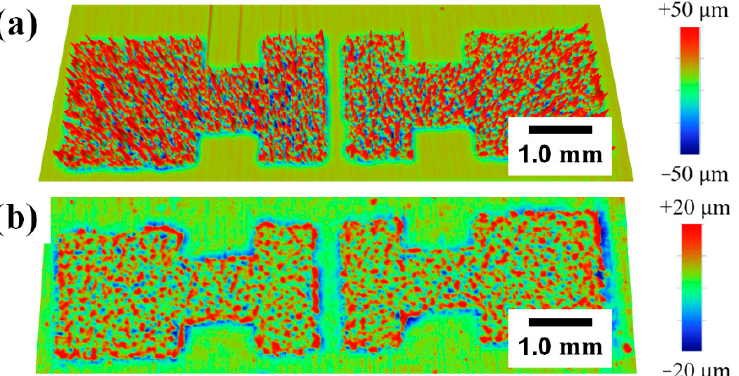
Figure 7. Surface 3D profile images of EEG S/D electrodes after ( a ) spray coating onto Cu foil and ( b ) hot pressing. ( b ) hot